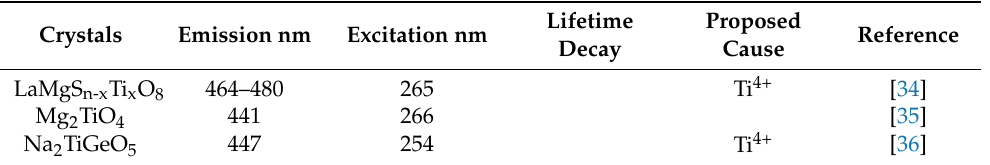
Table 2. Summary of luminescent properties of Ti-bearing synthetic compounds for which BSL has been documented. For all, the perceived luminescence color is blue.